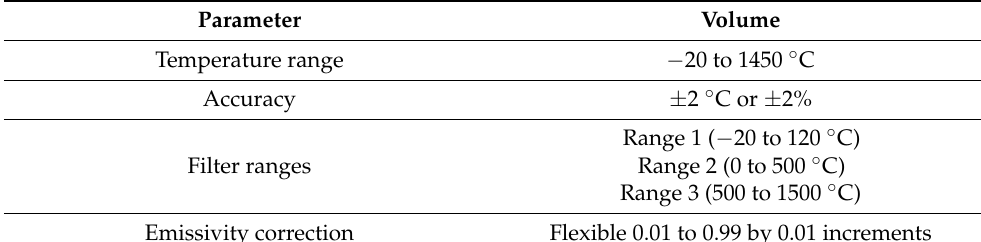
Table 2. Specifications of thermal